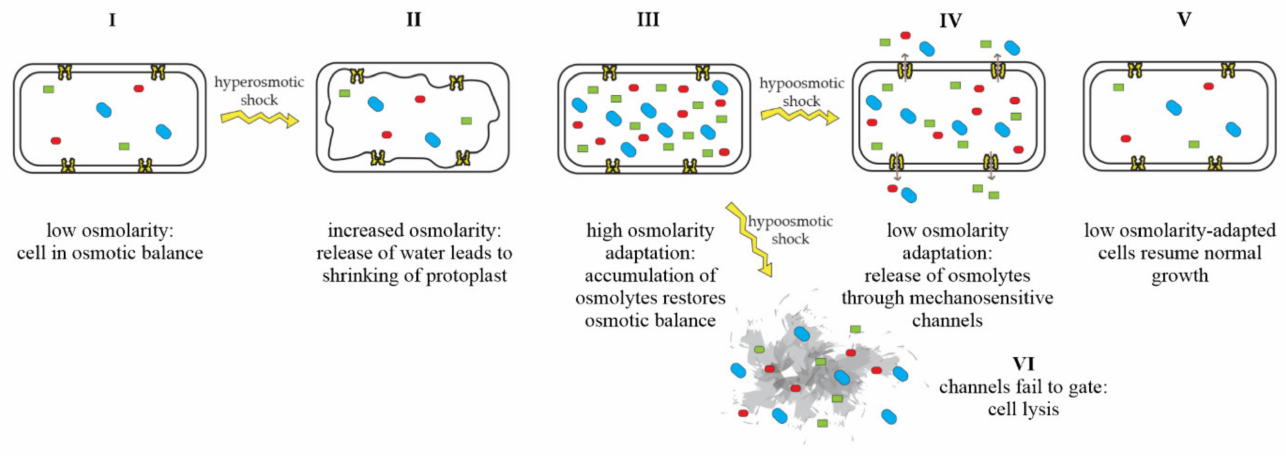
Figure 1. Adaptation of bacterial cells to changing osmotic pressure. A sudden increase in osmolarity leads to loss of water and shrinking of the protoplast, counteracted by the accumulation of compatible solutes, which raise intracellular-solute concentrations and restore the cell’s osmotic balance ( I – III ). A sudden decrease in osmolarity leads to an influx of water, resulting in increased turgor pressure, which is relieved by the opening of mechanosensitive channels and subsequent release of osmolytes into the environment ( IV ), restoring osmotic balance ( V ). If mechanosensitive channels fail to gate, cells lyse ( VI ). Figure adapted from Booth et al.